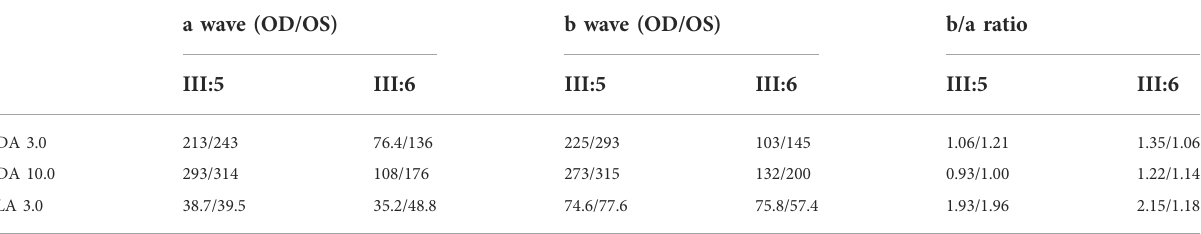
TABLE 2 ERG responses for probands III:5 and